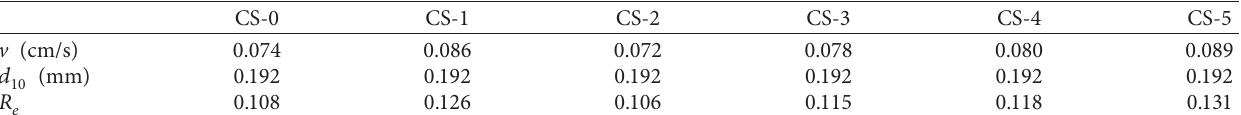
Figure 10: Clay loss percentage for CFC and FC groups. (a) Percentage of clay loss. (b) Clay loss variation with fine sand loss. Table 5: Reynolds number of the CS group.